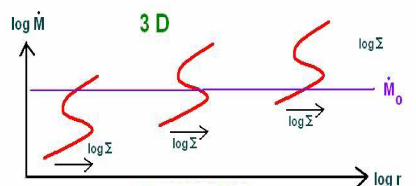
Figure 1. Schematic illustration of the stability curve of an optically thick disk at a few distances from a black hole. A single Σ − ˙ M picture shows the dependence of the disk surface density, Σ , on the accretion rate ˙ M . The positive slope describes the stable branch (gas-pressure-dominated lower branch, advection-dominated upper branch), the intermediate radiation-pressure-dominated branch is unstable. The whole curve position shifts up with increasing radius, so when we look at the location where the external assumed accretion rate crosses the plots we see (for high accretion rate) an inner, stable advection-dominated branch, an intermediate unstable zone, and an outer stable gas-dominated